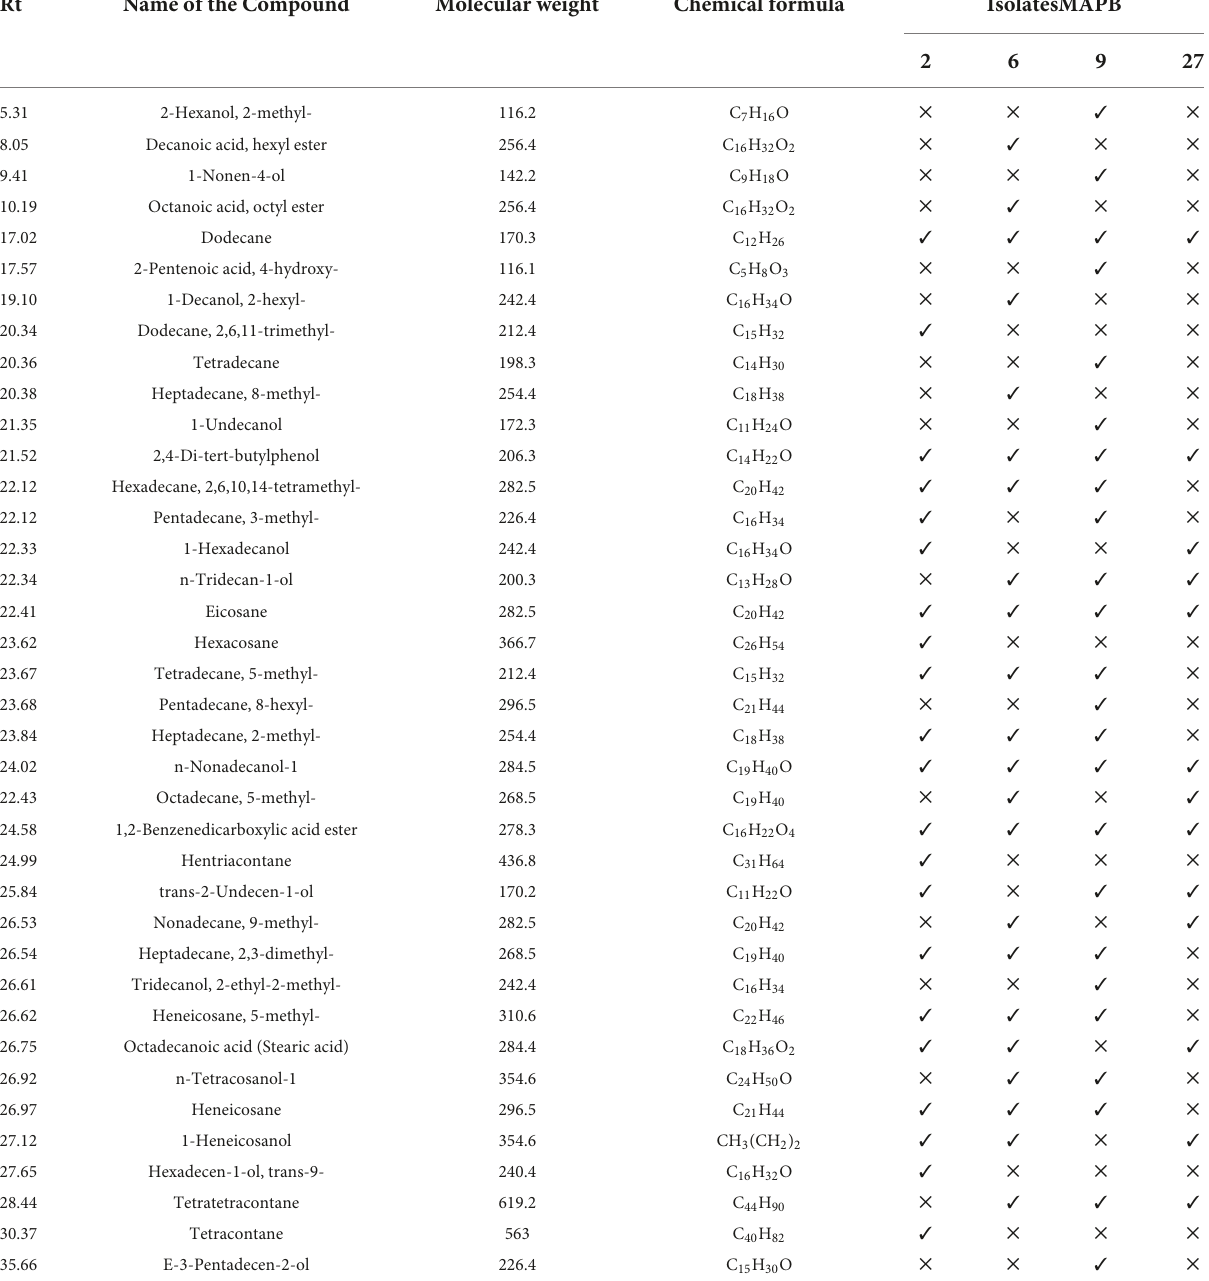
TABLE 4 GC-MS/MS analysis and characterization of identified compound from biosurfactant. Rt